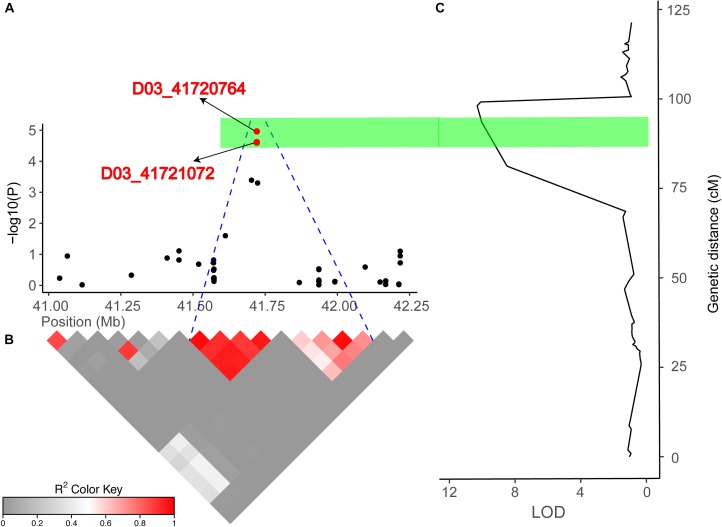
Combined results of the association mapping and linkage analysis of chromosome D03. (A) Peak region (41.03–42.21 Mb) on chromosome D03. (B) Pairwise LD between the SNP markers is indicated as D′ values, where dark red indicates a value of 1, and gray indicates a value of 0. The blue dotted line shown in (A) indicates the LD blocks that contain two significant SNPs (red dots). (C) The right part is the linkage map and the results of the linkage mapping, and the green bar indicates overlapping regions across the GWAS and linkage mapping results.